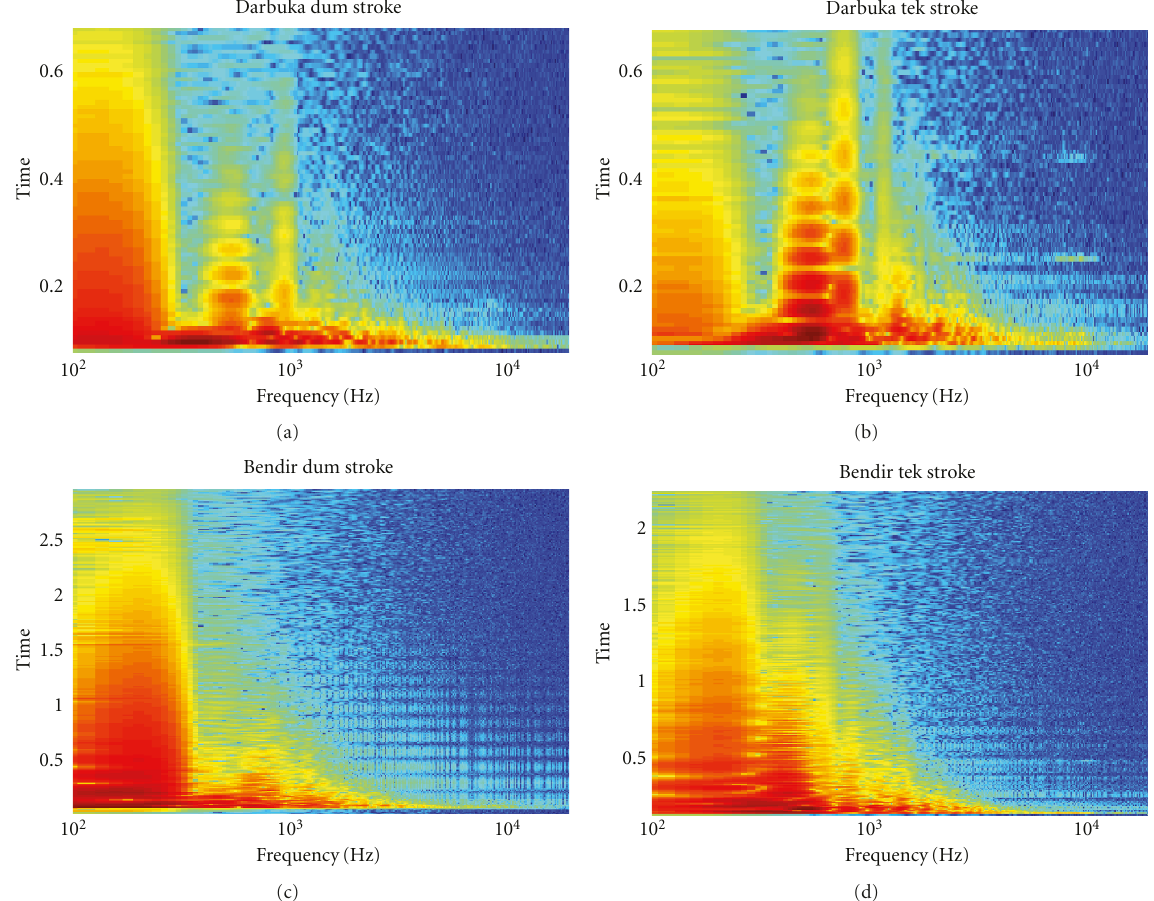
Figure 4: Spectrograms of exemplary d¨um and tek strokes on the Darbuka (top) and the Bendir (bottom).